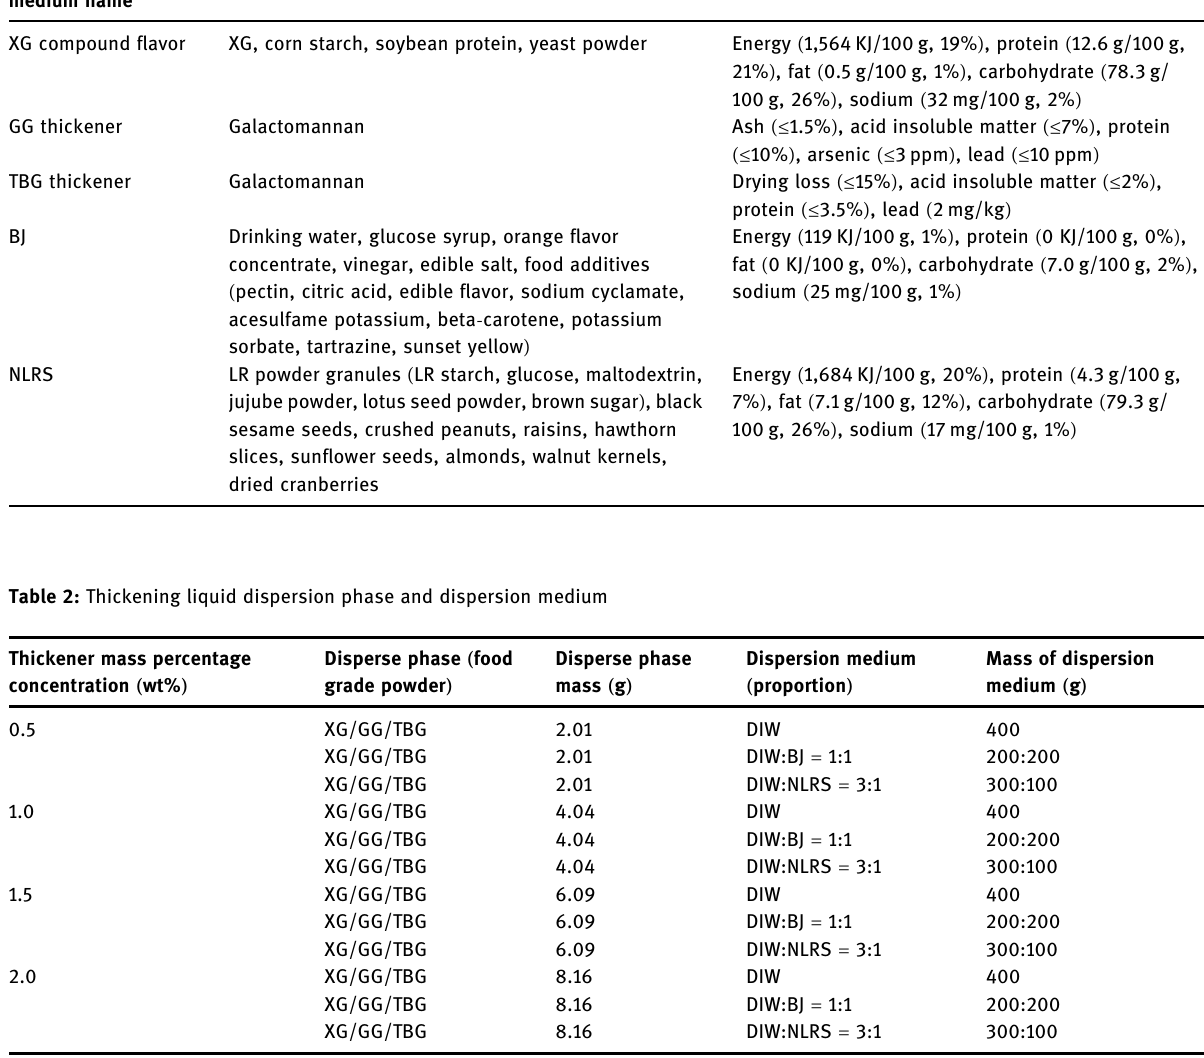
Table 1: Commercial powder thickeners and dispersing medium Thickener/dispersing medium name